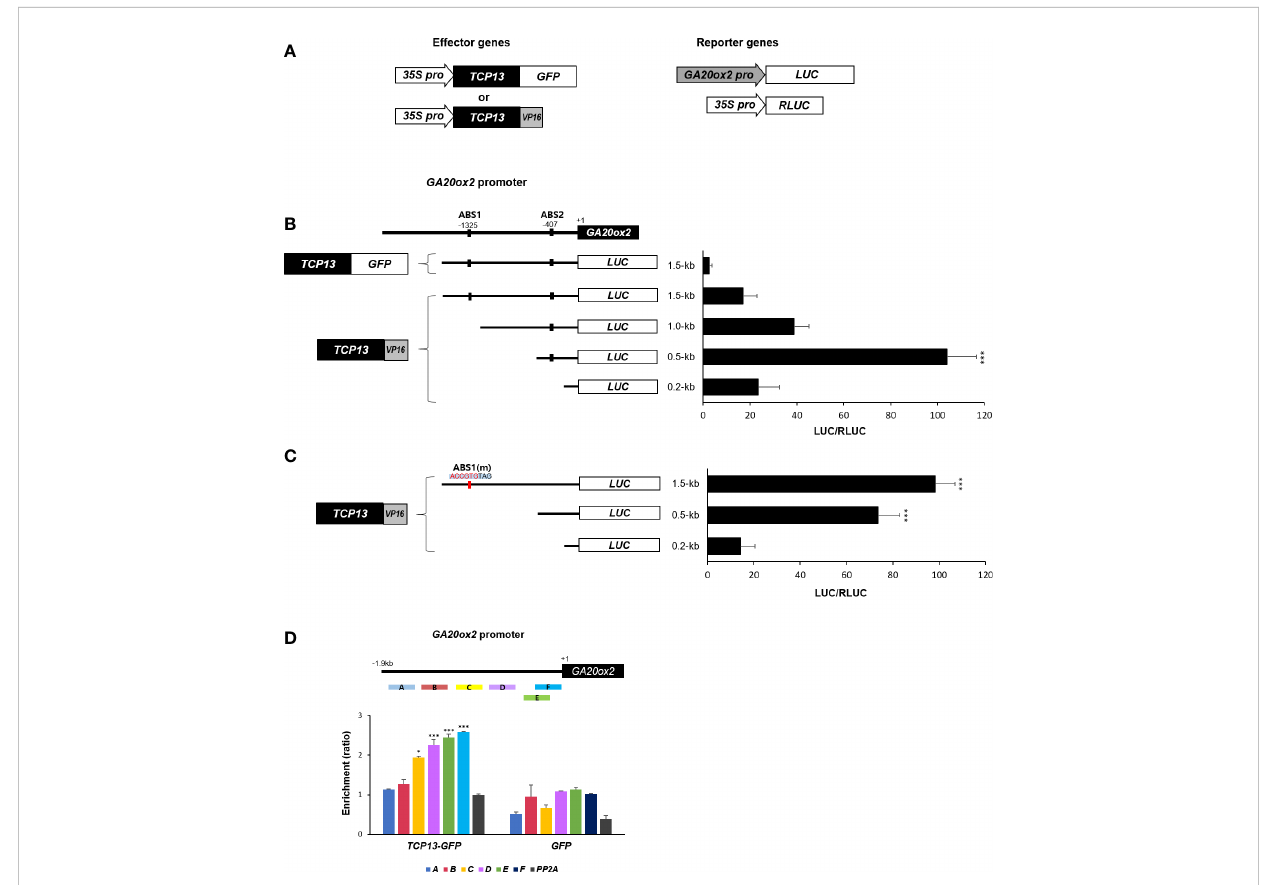
FIGURE 5 Regulation of GA20ox2 by TCP13. (A) Luciferase assays using different lengths of GA20ox2 upstream region fused with fi re fl y luciferase ( GA20ox2 pro::LUC ) as reporters and 35S pro::TCP13-GFP or 35S pro::TCP13-VP16 as effector constructs were performed. (B) Different lengths of GA20ox2 upstream region (1.5-kb, 1.0-kb, 0.5-kb, and 0.2-kb upstream regions) fused with fi re fl y luciferase were used as reporter constructs, and 35S pro:: RLUC was used as internal control. Fire fl y luciferase (LUC) activity was normalized with Renilla luciferase (RLUC) activity. (C) ABS1 on GA20ox2 promoter was mutated; ABS1(m). The resulting construct was used for luciferase assay. (D) ChIP assay showing enrichments of GA20ox2 promoter fragments by TCP13. Schematic diagram indicates ChIP amplicons (A – F) in the upstream region of GA20ox2 . The enrichment of each DNA fragment was normalized by the level of input DNA and the ChIP enrichment value of the control PP2A promoter. Asterisks indicate signi fi cant differences from the enrichment of PP2A genomic fragments. Results are representative of three independent experiments. Data shown are mean ± SD (n=3). All data were statistically evaluated using one-way ANOVA: *P < 0.05; ***P <